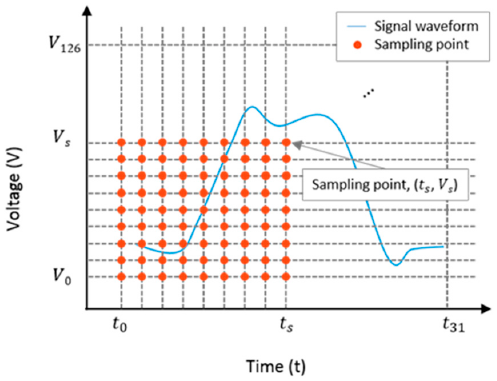
Figure 4. Bit error rate (BER) sampling points of the monitoring system.